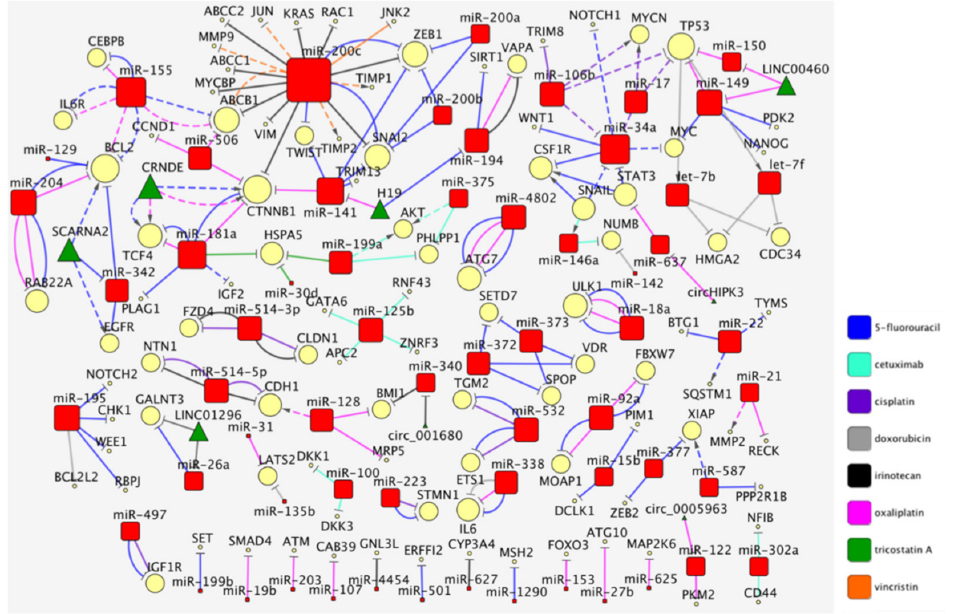
Figure 1. The molecular networks of miRNAs and their targets in colon cancer drug resistance. Each network shows the miRNAs/targets (nodes), or drug resistances (edges) described in at least two articles. MiRNAs are identified with red, rounded squares and the targets with yellow circles. The connecting edges corresponds to the drug resistance (color-coding for the drugs is reported in the legend). We used continuous lines for pairwise (first order) interactions and dashed for secondary (higher order) ones. Flat arrows indicate repression, while pointed arrowheads indicate activation. The map size of the miRNAs (red squares), targets (yellow circles) and non-coding RNA upstream regulators (green triangle) depends on the node degree. The data used to generate the networks are listed in Table